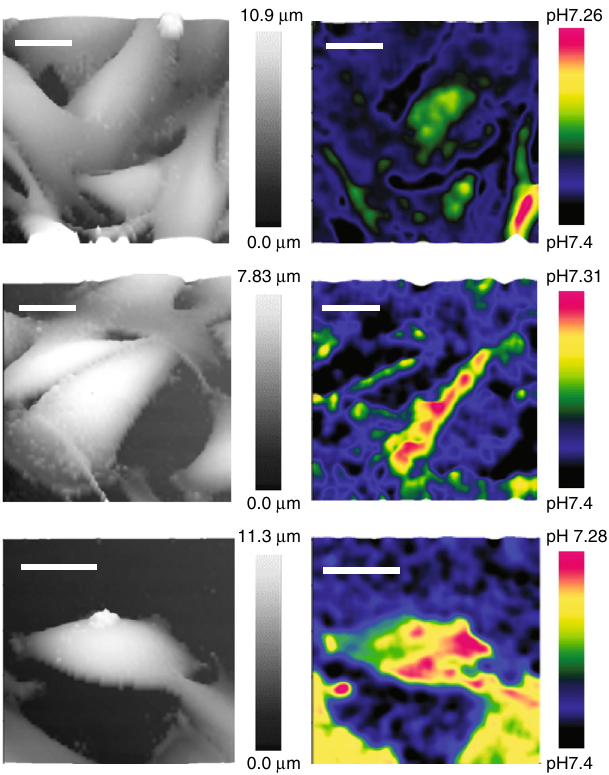
Fig. 4 High-resolution 3D pHe mapping of living melanoma cells. The 3D SICM topographical images (left column) and 3D pHe distributions (right column) of three different groups of low-buffered living melanoma A375M obtained simultaneously. Scale bars represent 20 µ